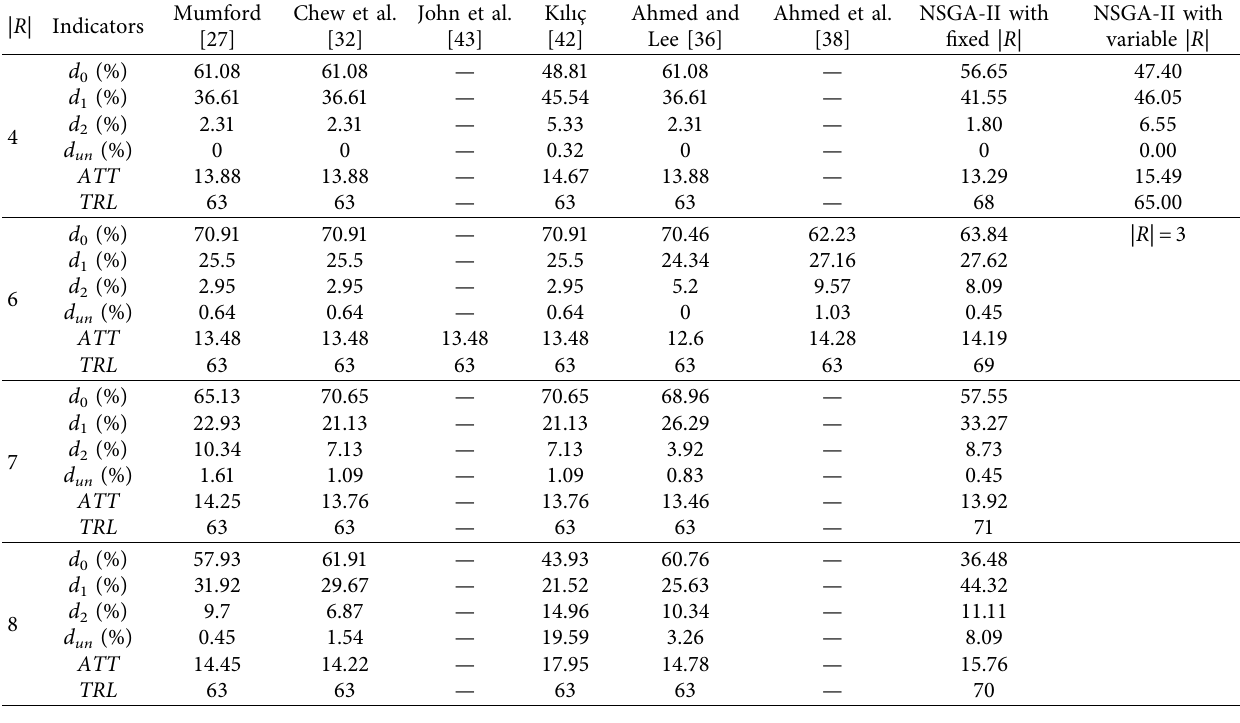
Table 9: Operator perspective results compared to other approaches for Mandl’s